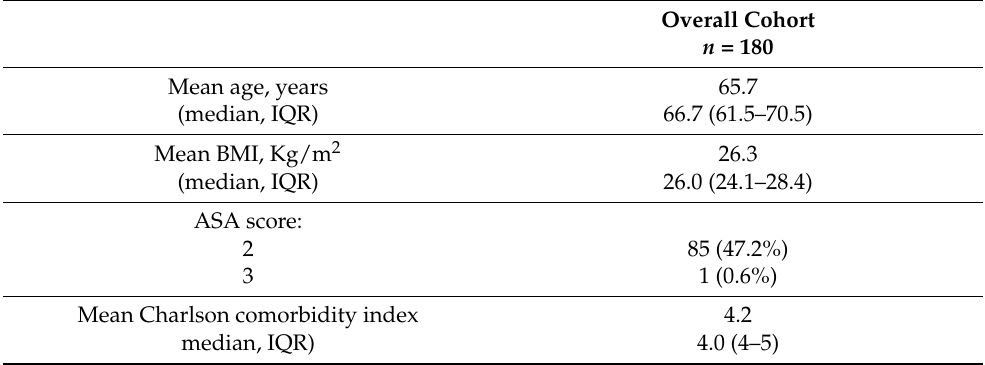
Table 1. Overall cohort clinical, perioperative and pathological